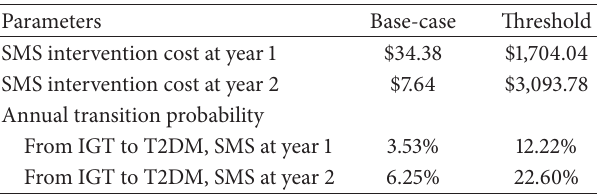
Table 5: Threshold analysis of parameters at which the costs of SMS intervention and control became equivalent over a 50-year